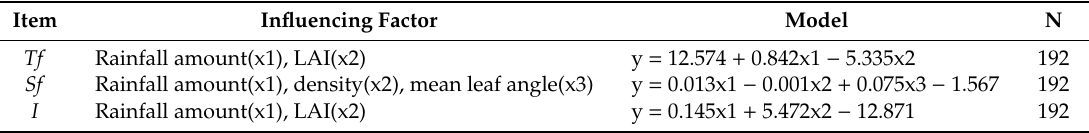
Table 6. Stepwise analysis of rainfall partitioning